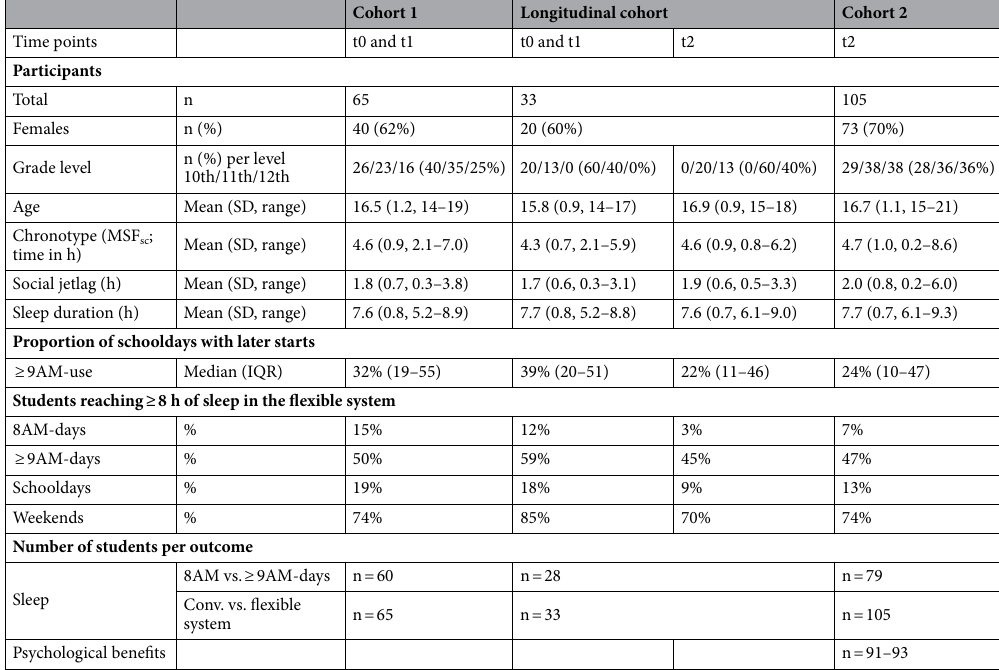
Table 1. Composition of study cohorts. Displayed are cohort characteristics after standard filter criteria. An additional filter (see “Participant” section in “Methods”) was applied for comparisons between 8AM and ≥ 9AM-days, which reduced cohort 1 to 60 students, the longitudinal to 28 students, and cohort 2 to 79 students. n, number of individuals; SD, standard deviation; IQR, interquartile range; conv.,